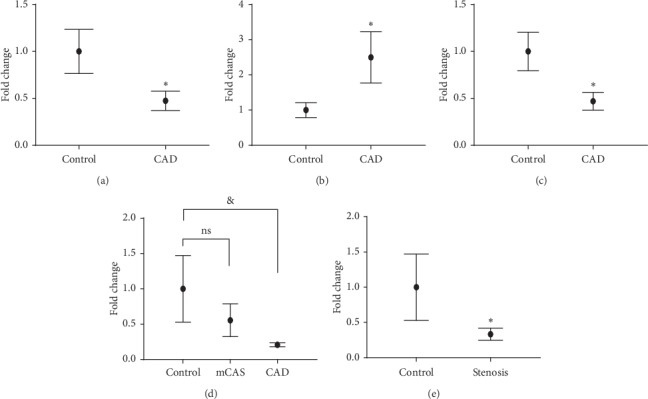
Validation of differentially expressed plasma exosomal miRNAs by quantitative real-time PCR (qRT-PCR). (a) Relative expression of AC017053.1 in plasma exosomes from 24 CAD patients and 24 controls. (b) Relative expression of NONHSAT138339 in plasma exosomes from 24 CAD patients and 24 controls. (c) Relative expression of SOCS2-AS1 in plasma exosomes from 24 CAD patients and 24 controls. (d) Relative expression of SOCS2-AS1 in plasma exosomes from 84 CAD patients, 48 mCAS patients, and 41 controls. (e) Relative expression of SOCS2-AS1 in plasma exosomes from the stenosis group (merged 84 CAD patients and 48 mCAS patients) and 41 controls. ∗P < 0.05; & P < 0.01.